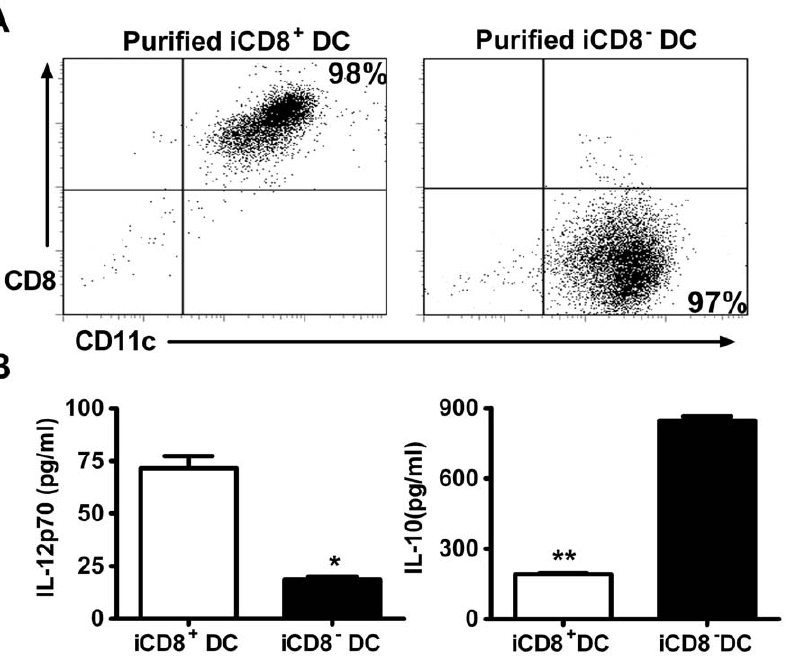
Figure 2. Different levels of cytokine production by DC subsets. DC subsets were isolated from spleens of BCG infected (i.v.) mice at day 21 post-immunization as described in the Materials and Methods. A, purified DC subsets were analyzed by flow cytometry for purity. The 5 6 10 5 sorted cells were co-stained with APC-conjugated anti-CD11c and PE-conjugated anti-CD8. The purities of the sorted iCD8 + DC (left) and iCD8 2 DC (right) are indicated at the right upper corner and right lower corner respectively. B, freshly isolated iCD8 + DC and iCD8 2 DC subsets were cultured. The culture supernatants were harvested at 72 h and tested for IL-10 and IL-12p70 by ELISA. Data are shown as mean 6 SD of each group. One representative experiment of three independent experiments with similar results is shown.*p , 0.05, **p , 0.01.